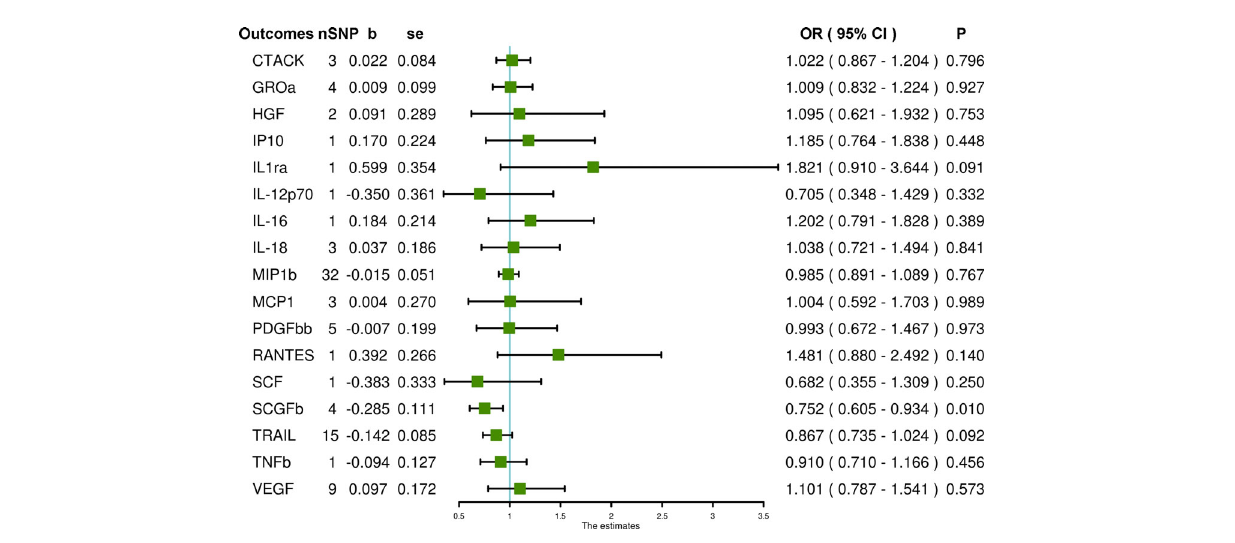
FIGURE 1 | The association of systemicin fl ammatory regulatorswith PCOS using SNPs at the genome-wide signi fi cance level (P< 5 × 10 – 8 ): the inverse-variance weighted (IVW)method was applied as the primarymethodfor MRanalysis. SNP, singlenucleotide polymorphism;b,betacoef fi cient; se, standard error;OR, odds ratio; CI, con fi dence interval;MR-PRESSO, Mendelian randomization pleiotropyresidualsum and outlier;CTACK, cutaneous T-cellattracting chemokine; GROa, growth-regulated protein alpha; HGF, hepatocyte growth factor;IP10, interferon gamma-induced protein 10; IL1ra, interleukin-1-receptor antagonist; IL-12p70, interleukin-12p70; IL-16, interleukin-16; IL-18, interleukin-18; MIP1b, macrophagein fl ammatory protein 1b; MCP1, monocyte chemoattractant protein-1; PDGFbb, platelet-derived growth factorBB; RANTES, regulated on activation, normal T cellexpressed and secreted; SCF, stem cell factor; SCGFb, stem cellgrowth factor beta; TRAIL,TNF-related apoptosis-inducing ligand; TNFb, tumornecrosisfactorbeta; VEGF,vascular endothelial growth